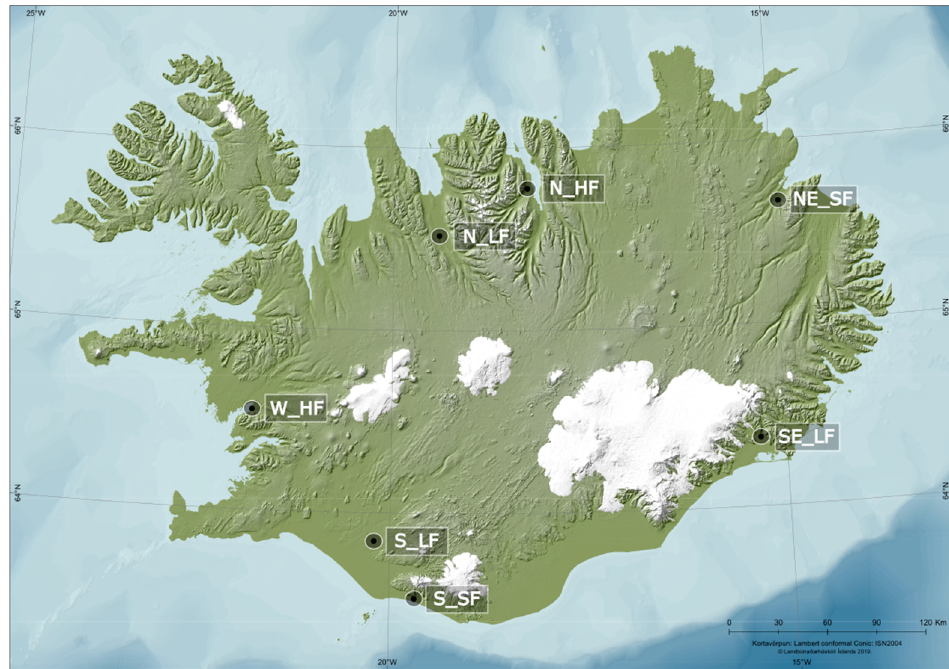
Figure 1. Locations of trails in Iceland and environmental codes. Locations are scattered across two latitude degrees and across the country in regions where barley cultivation is practiced. S: south; N: north; W: west; SE: southeast; NE: northeast; SF: semi-fertility; LF: low fertility; HF: high fertility.